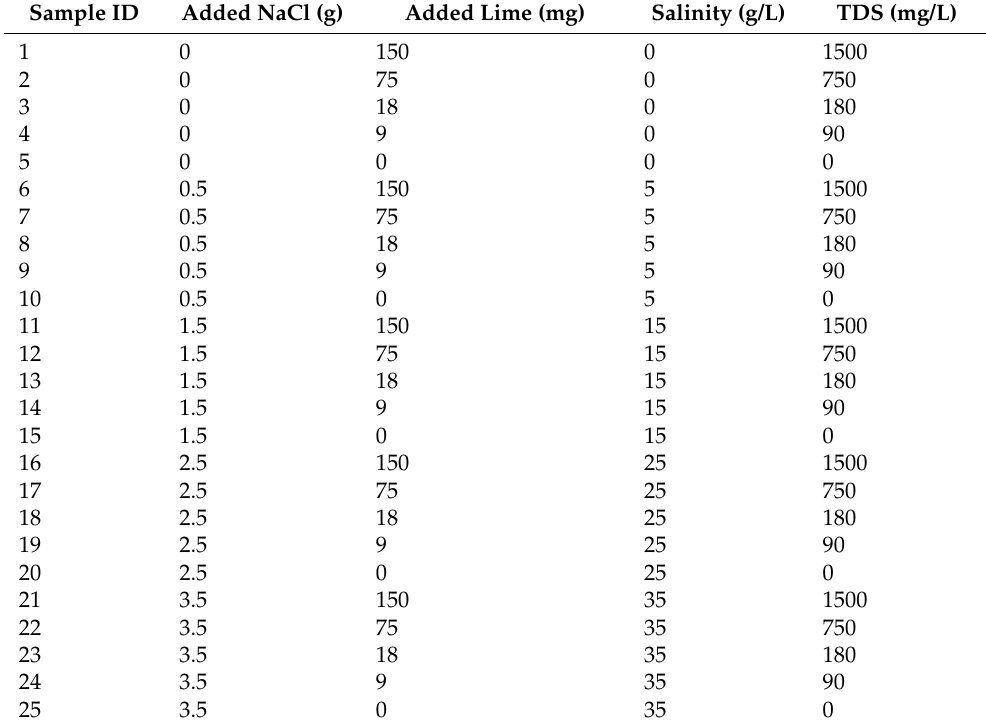
Table 1. Samples for the salinity sensor